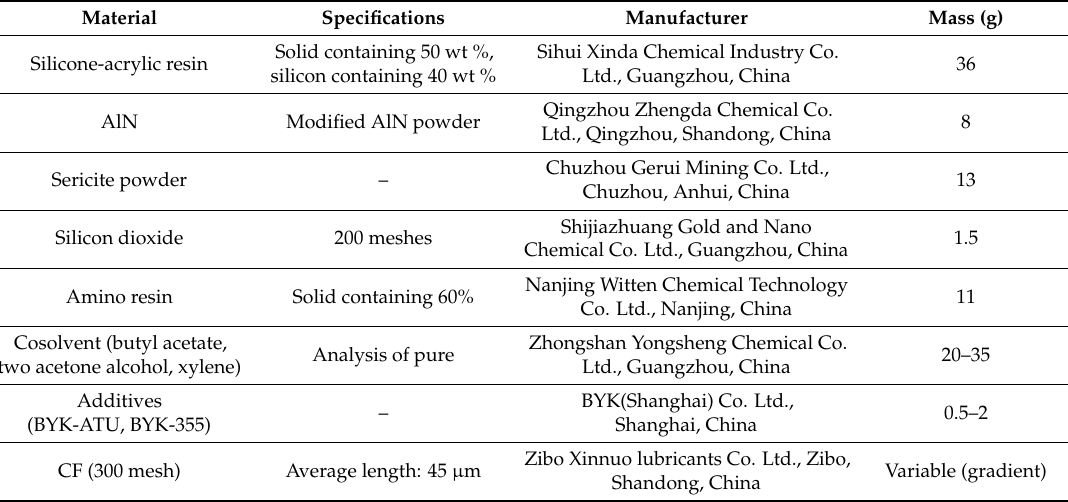
Table 2. The detailed information of the raw materials and